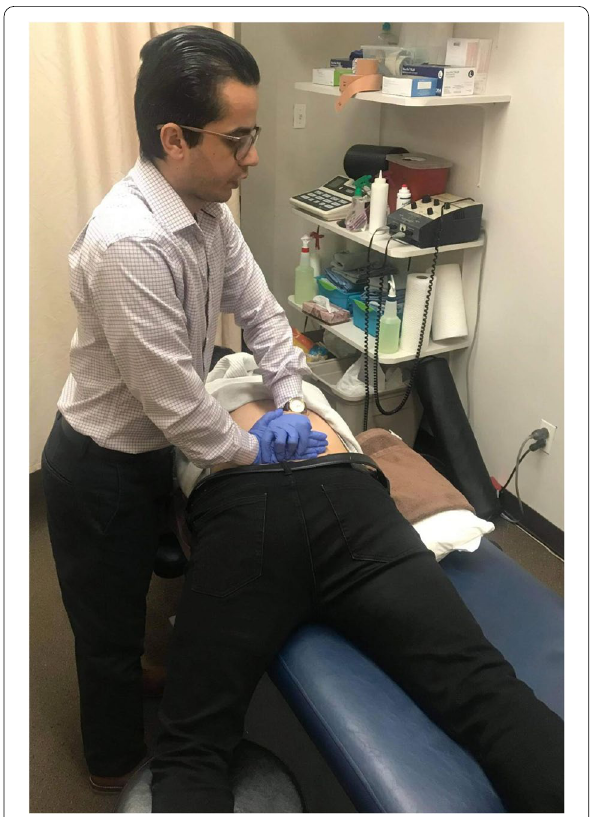
Fig. 2 Positional release technique of piriformis